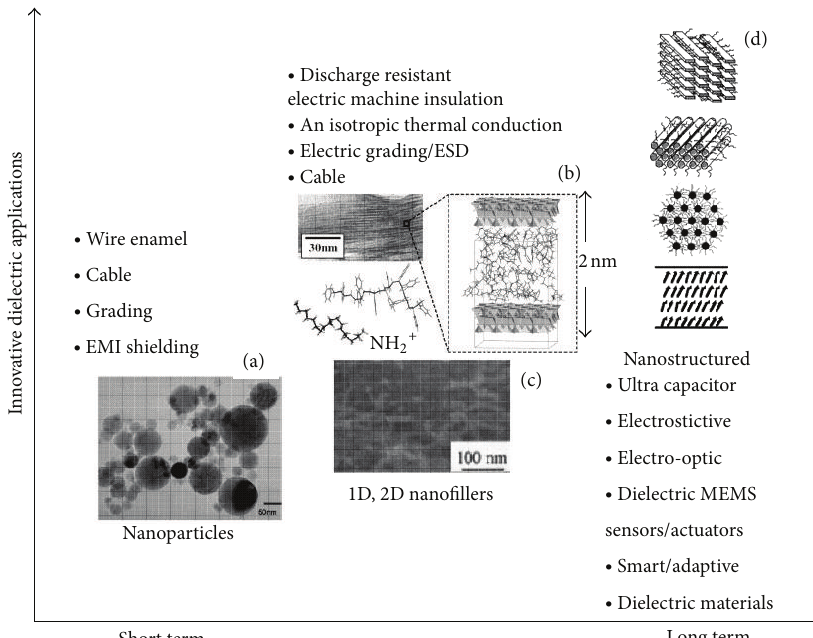
Figure 15: Recent and future development trends of nanocomposites over time